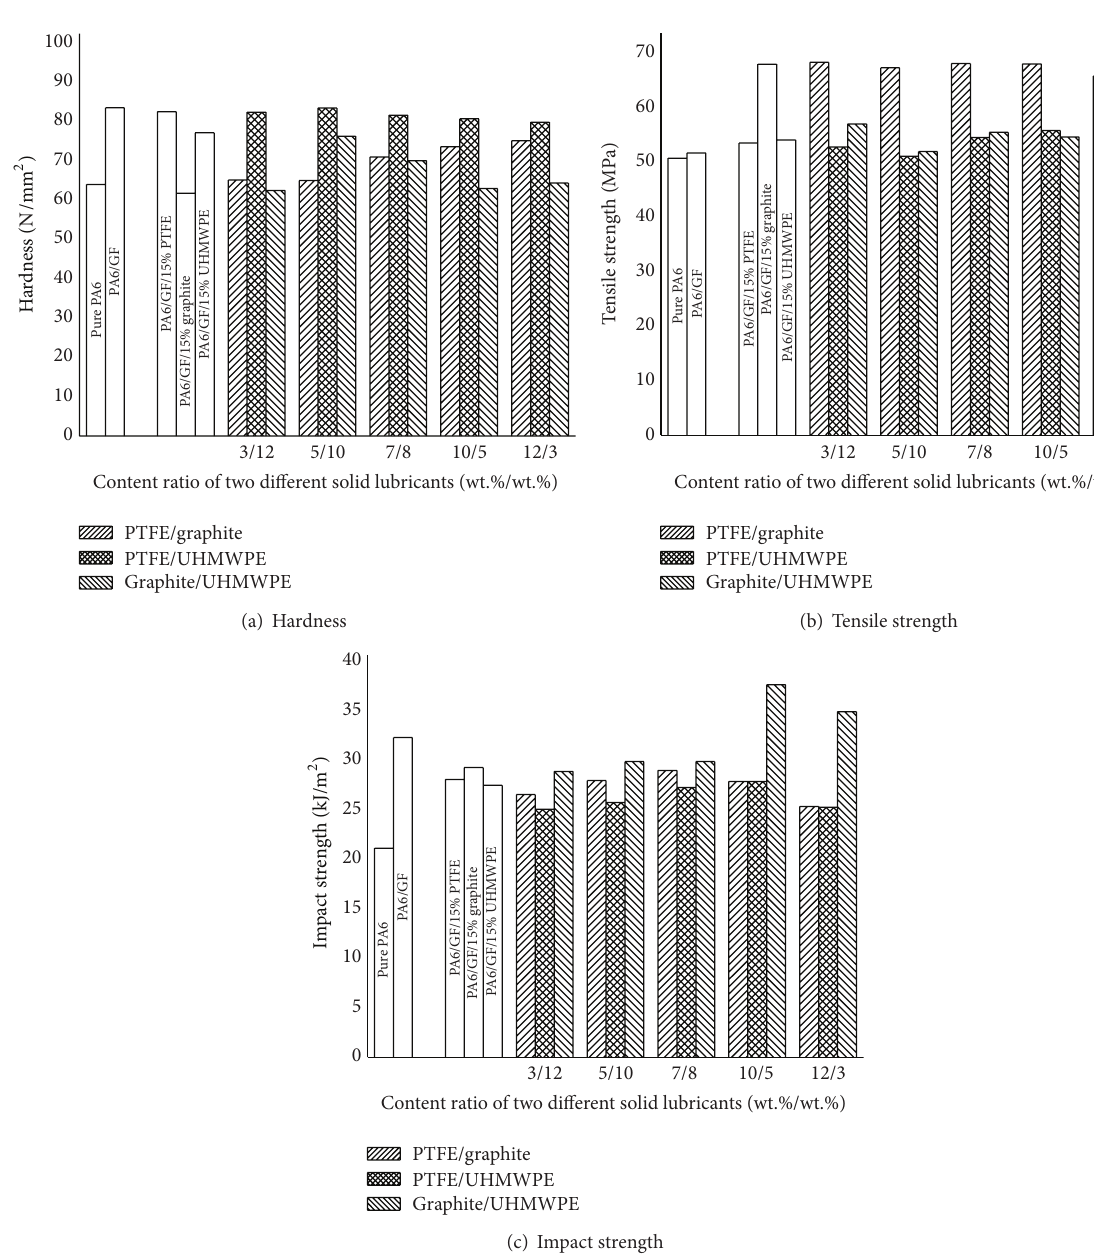
Figure 2: Mechanical property of PA6/GF composites filled with complex solid